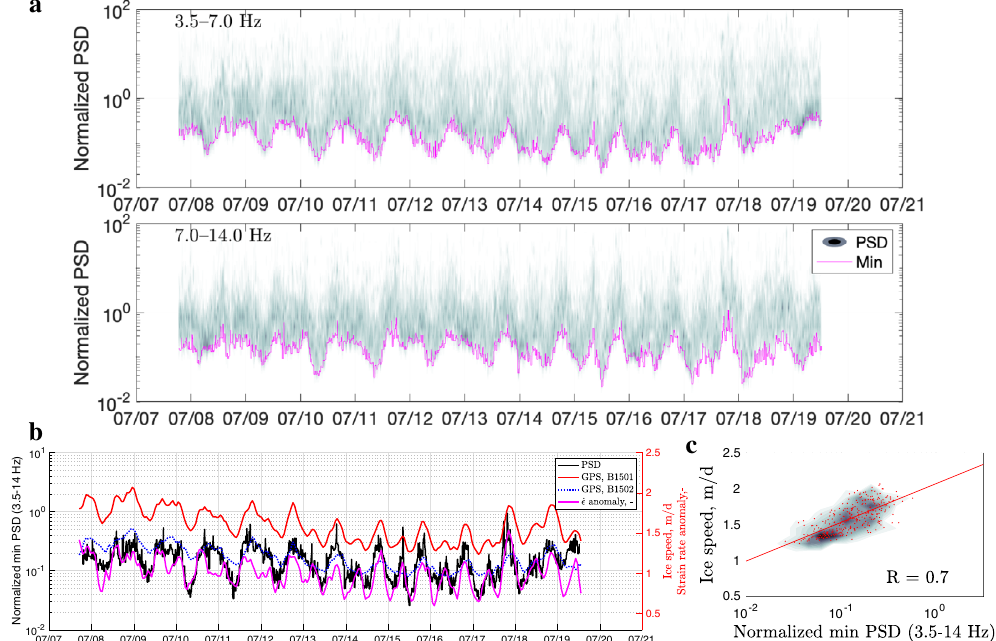
Fig. 7 Analysis of data from the 2015 on-ice station (ICC). a Density plots of the normalized noise amplitude variations for 3.5 – 14.0 Hz frequency bands (for velocity power spectral density, PSD). Each magenta curve marks the lowest noise level in a given band. The colour scale is the same as in Fig. 2c (0 – 35). b Minimum seismic tremor amplitude (3.5 – 14.0 Hz) versus glacier displacement rate at Global-Positioning-System (GPS) stations B1501 and B1502, with the corresponding strain rate anomaly, _ ϵ (i.e., deviation from the mean). c Scatter and density plots showing the correlation between the seismic signal and horizontal GPS displacement rate at B1501 for overlapping data ( R is the Pearson correlation coef fi cient). The red line is the regression fi